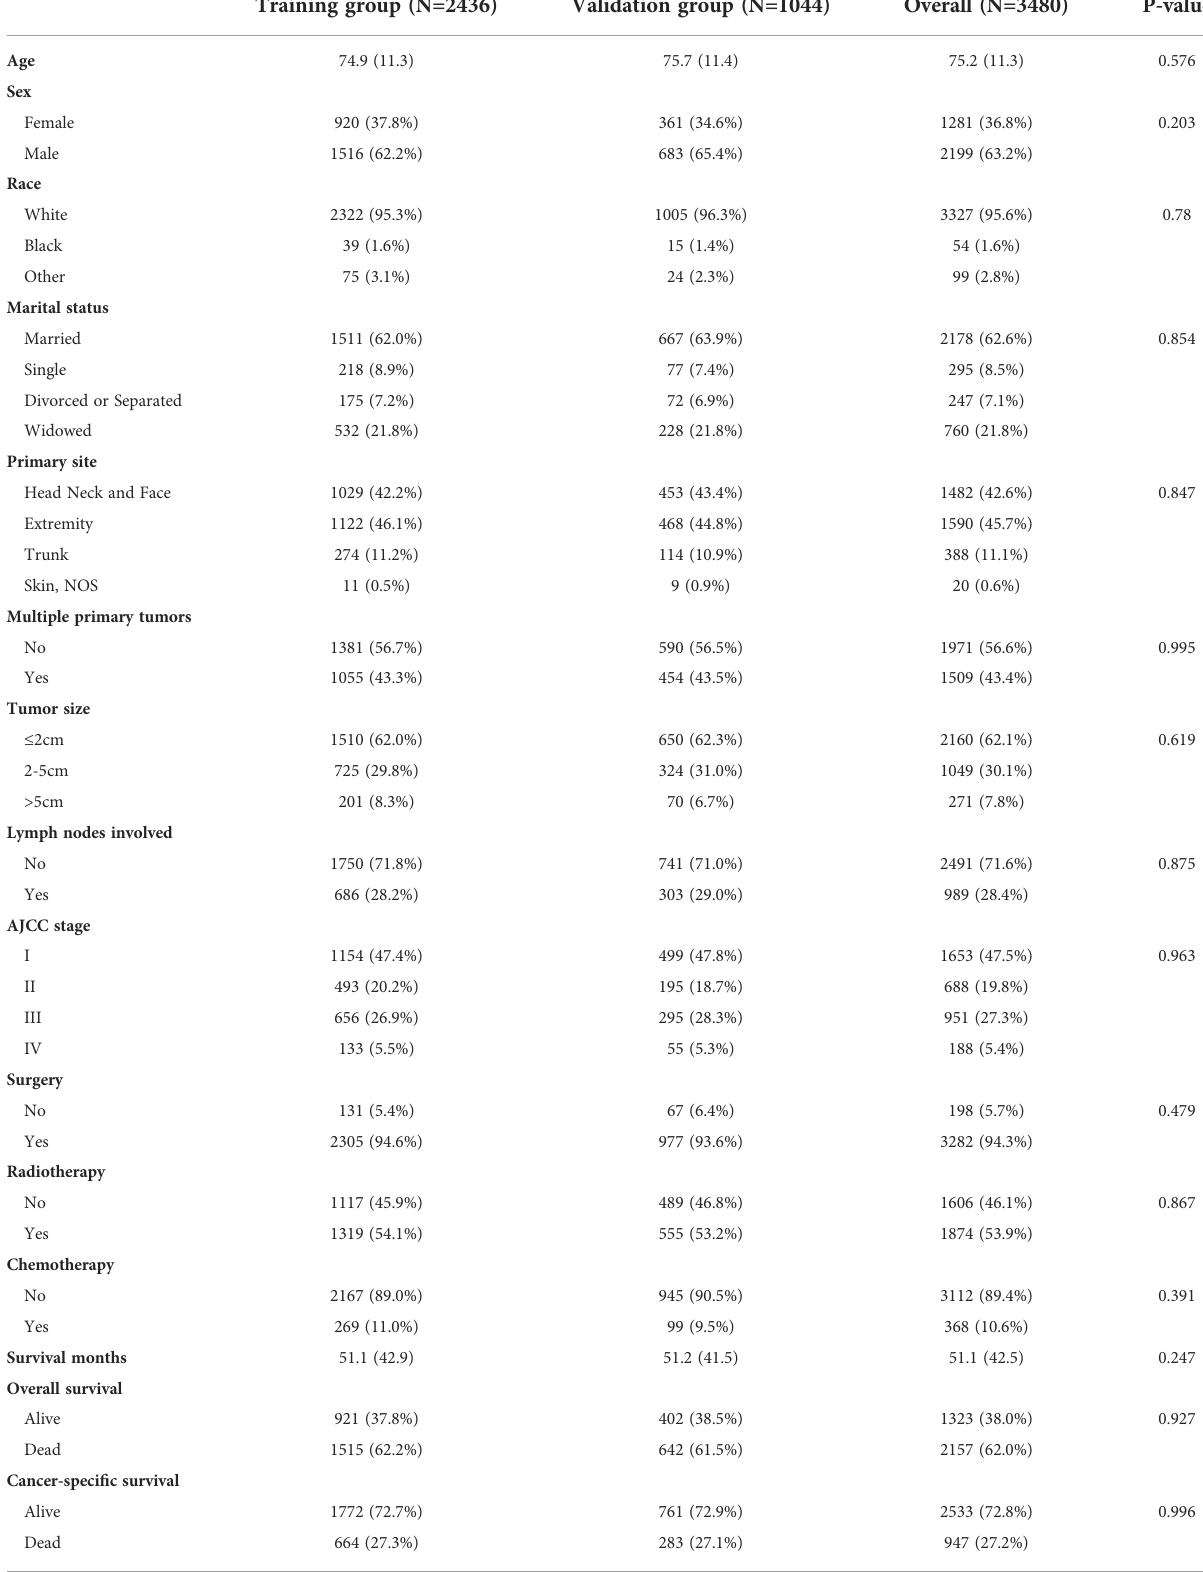
TABLE 1 The demographics and clinical features of patients with merkel cell carcinoma in different